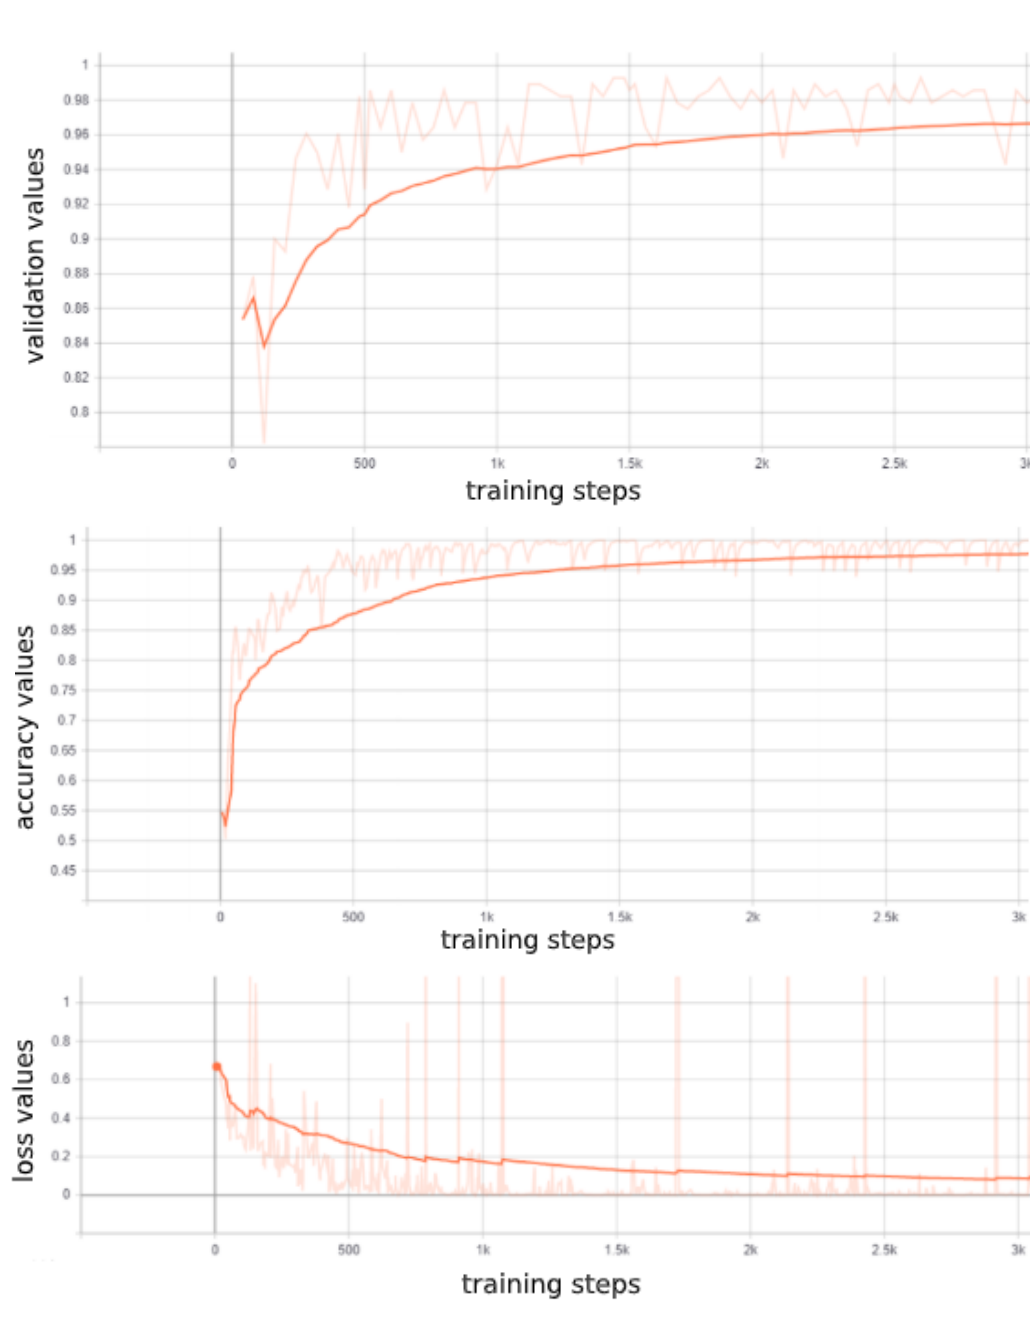
Figure 4. Validation, accuracy and loss functions.